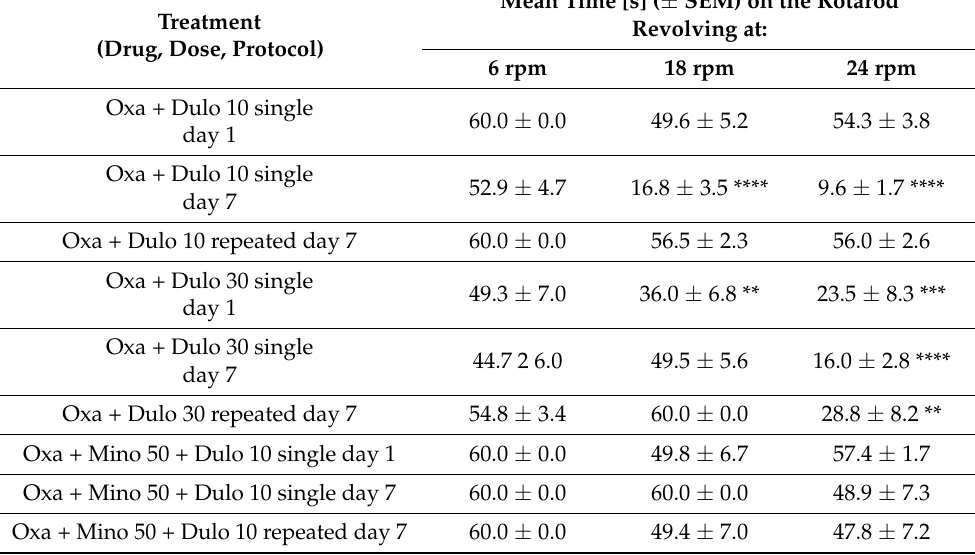
Mean Time [s] ( ± SEM) on the Rotarod Revolving